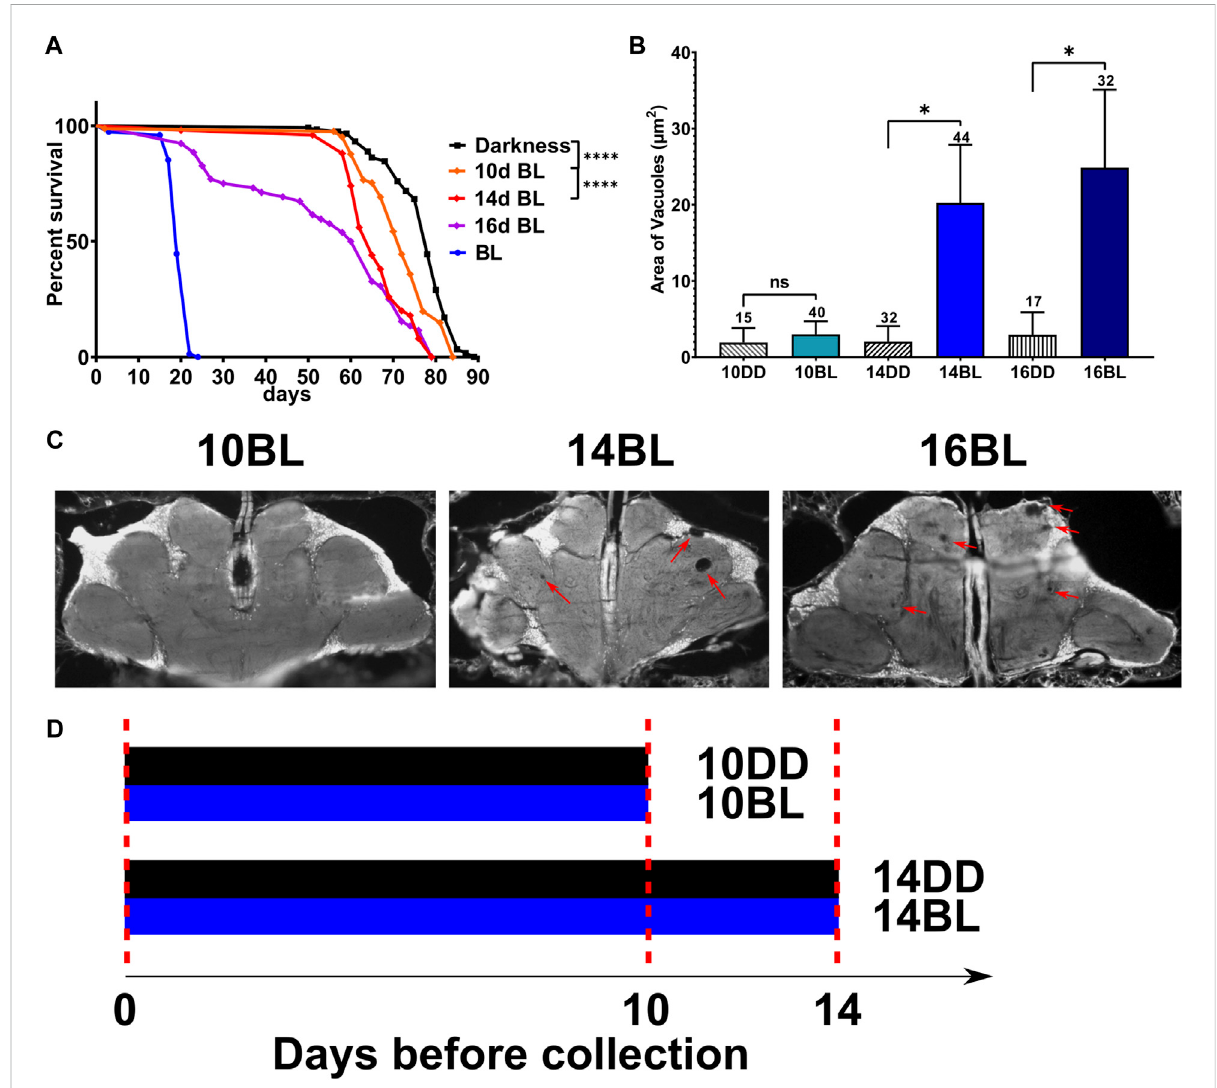
FIGURE 1 Effects of length of constant BL on lifespan and neurodegeneration in eya 2 fl ies. (A) Lifespan was measured in fl ies kept in constant darkness (DD),constantbluelight(BL),ortransferredfromBLtoDDafter10,14,or16 daysinBL).Starsindicatesigni fi cantdifferencesinsurvivalinBLbasedon statisticsbylog-ranktest( pppp p < 0.0001). (B) Quanti fi cationoftheaverageareaofvacuolesinheadsof fl iesexposedtoBLfor10,14,and16 days and their age-matched DD control. Statistics by unpaired t -test ( p p < 0.05) Numbers above bars indicate number of brains examined for each age and light condition. Error bars indicate standard error of the mean (SEM). (C) Representative images of brain sections showing brain vacuoles (red arrows) after indicated number of days in BL. (D) Scheme of the experimental design showing the treatment of fl ies collected for metabolomic pro fi